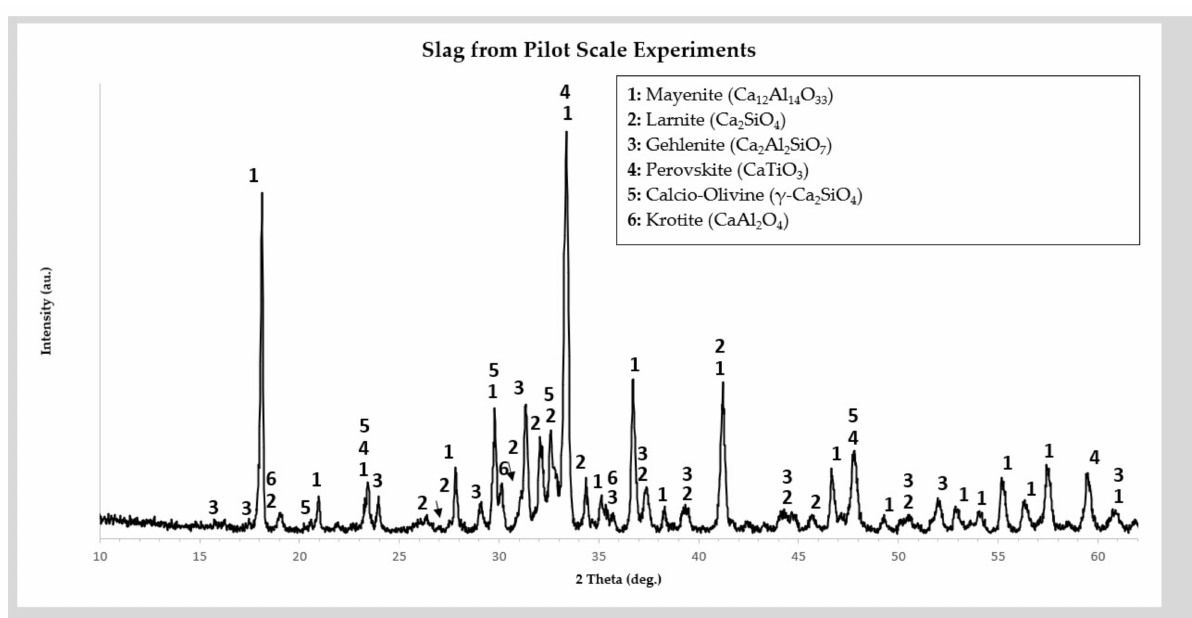
Figure 4. Powder X-ray Diffractogram and phase identification of the Ca-rich slag used for the pilot scale experiments of this study.